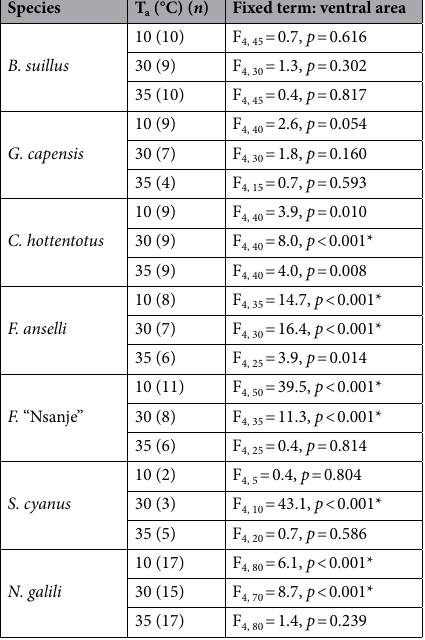
Table 5. The results of GLS models comparing the difference between core body and surface temperature (T diff ) among the five ventral areas at ambient temperature (T a ) of 10, 30 and 35 °C in each of the seven subterranean rodent species. For each T a , the venter was tested separately; n denotes to the number of individuals tested for each T a ; statistically significant results after Bonferroni correction α = 0.0024 applied are marked with an asterisk; post-hoc comparisons among the areas are depicted by letter combinations in Supplementary Fig. S1.